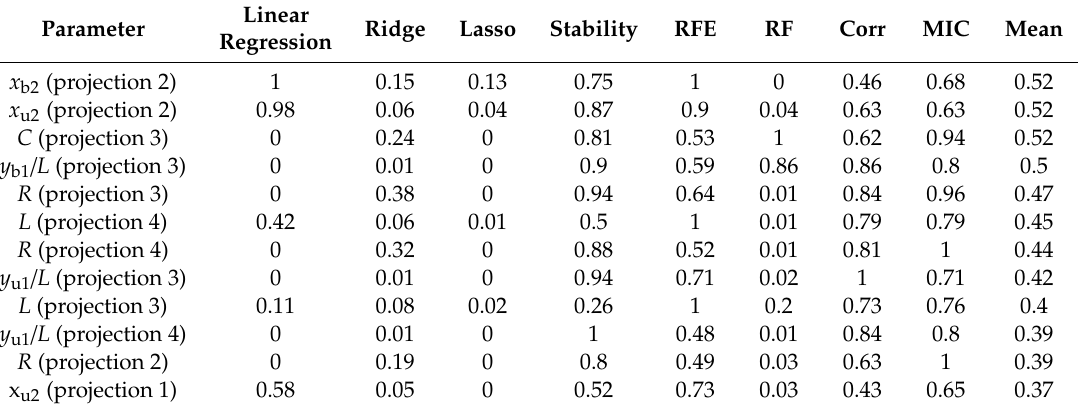
Table 4. Estimation of the measures of significance of spike quantitative characteristics for predicting spike density based on analysis of the images acquired by ‘clip’ protocol (the corresponding projections are parenthesized); characteristics are listed in column 1; significance values, in columns 2–9; and their means, in column 10. The significance measures are described in Methods, Section 2.4.2.